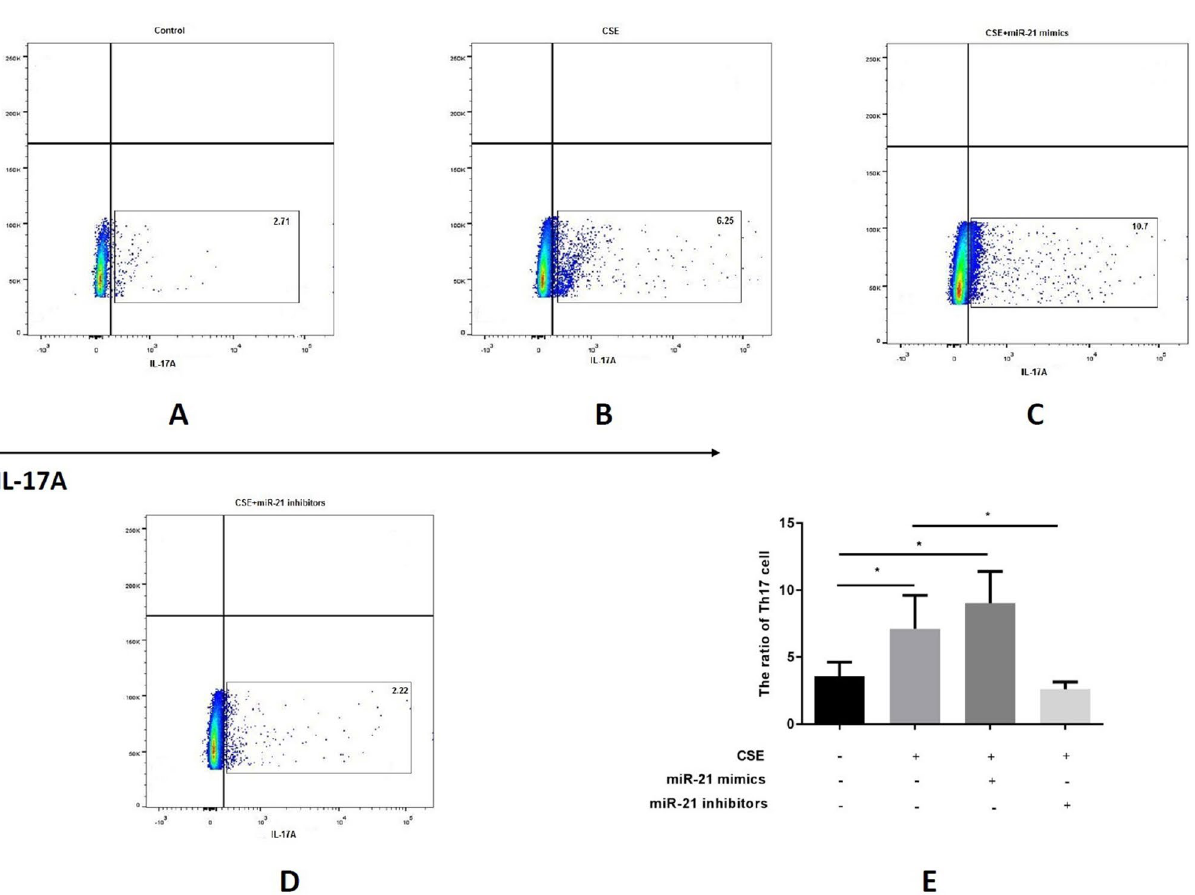
Figure 3. Th17 cell increased in COPD mice model and could be promoted by either CSE or miR-21. ( A – D ) Flow cytometry of IL-17A + cells in MACS-sorted CD4 + cells after different treatment (control, CSE, miR-21 mimics or miR-21 inhibitors respectively). ( E ) The quantification of IL-17A+ cells in CD4 + cells under different treatments. The CSE and miR-21 could both give rise the proportion of IL-17A + in CD4 + cells, meanwhile the miR-21 inhibitors work reversely. The data are expressed as the mean ± SEM (n = 5 in each group), t-test was applied in this part, *P <